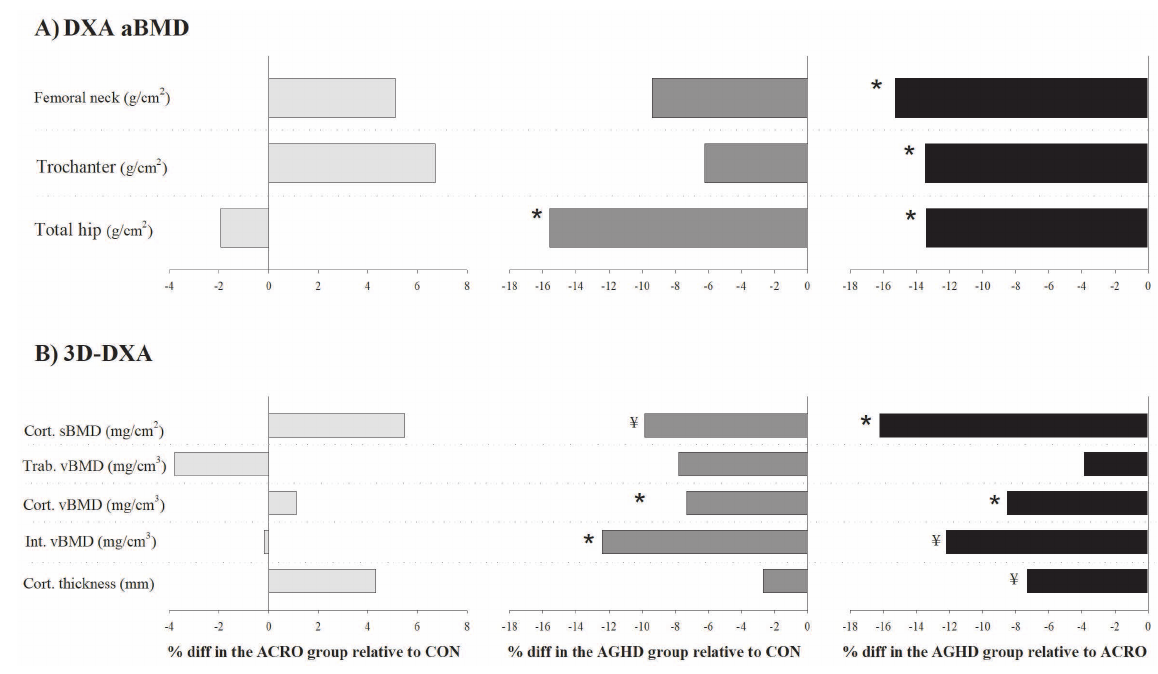
Figure 1. Adjusted differences (%) (by age, sex and body mass index) in ( A ) the areal bone mineral density (aBMD, g/cm 2 ) and ( B ) 3D-DXA parameters between patients with acromegaly ( n = 20), adult growth hormone deficiency (AGHD, n = 14) and the healthy control group ( n = 33). * p < 0.05 and ¥ p < 0.09 relative to the control group.